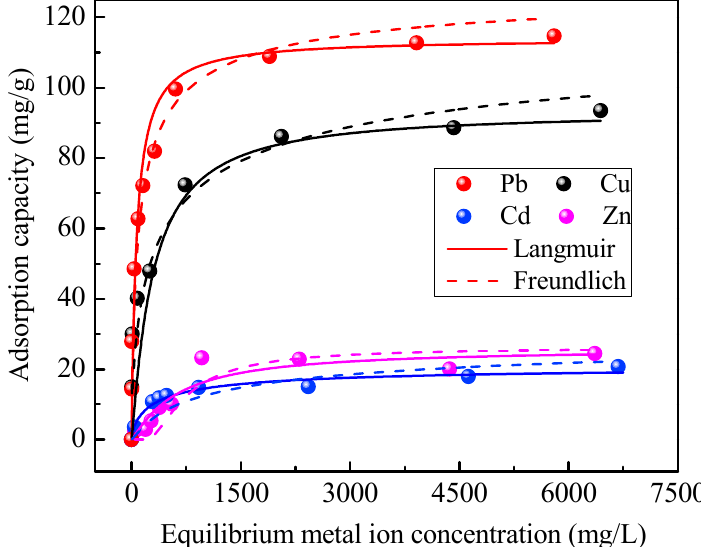
Figure 6. Adsorption isotherms of Pb(II), Cu(II), Cd(II) and Zn(II) onto the WAC-resin (liquid–solid ratio = 300 mL/g, time = 12 h, pH = 4 and room temperature).